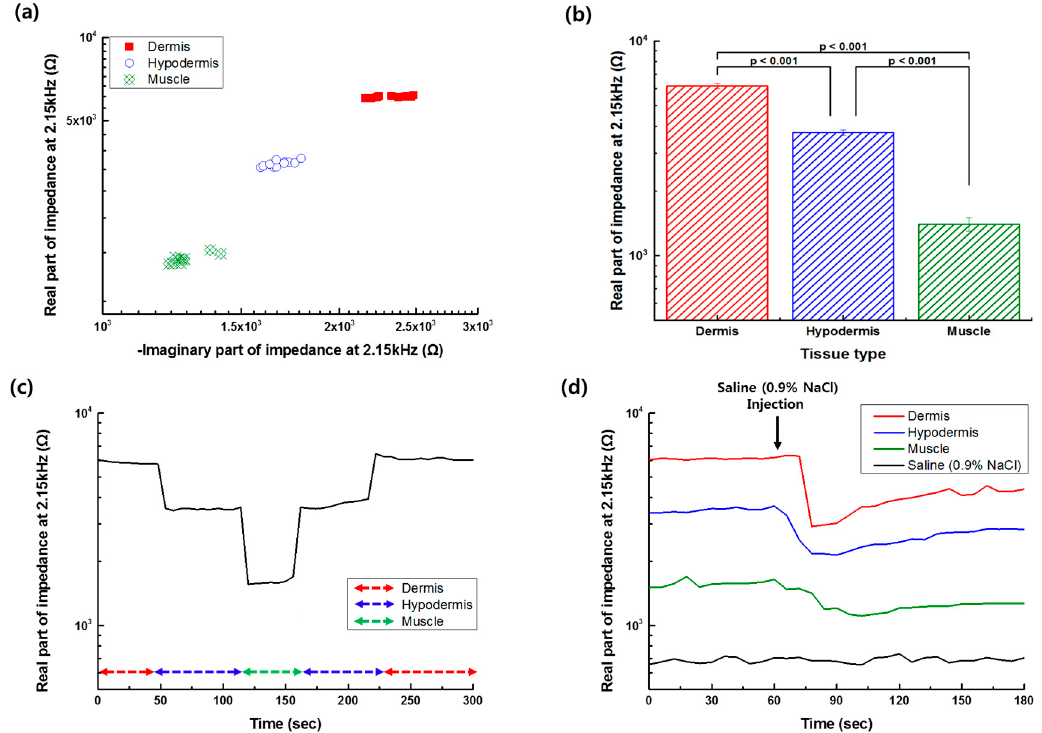
Figure 5. ( a ) Real and imaginary part of the impedance of the tissue layer measured at 2.15 kHz. ( b ) Difference of the average of the real part of the impedance at 2.15 kHz between the tissue layers (n = 3, bar: Standard error) evaluated by the Student’s t -test. ( c ) Monitoring of the real part of the impedance at 2.15 kHz, while the monopolar injection needle is moved to a different tissue layer. ( d ) Monitoring of the real part of impedance at 2.15 kHz during the saline injection process at different tissue layers.